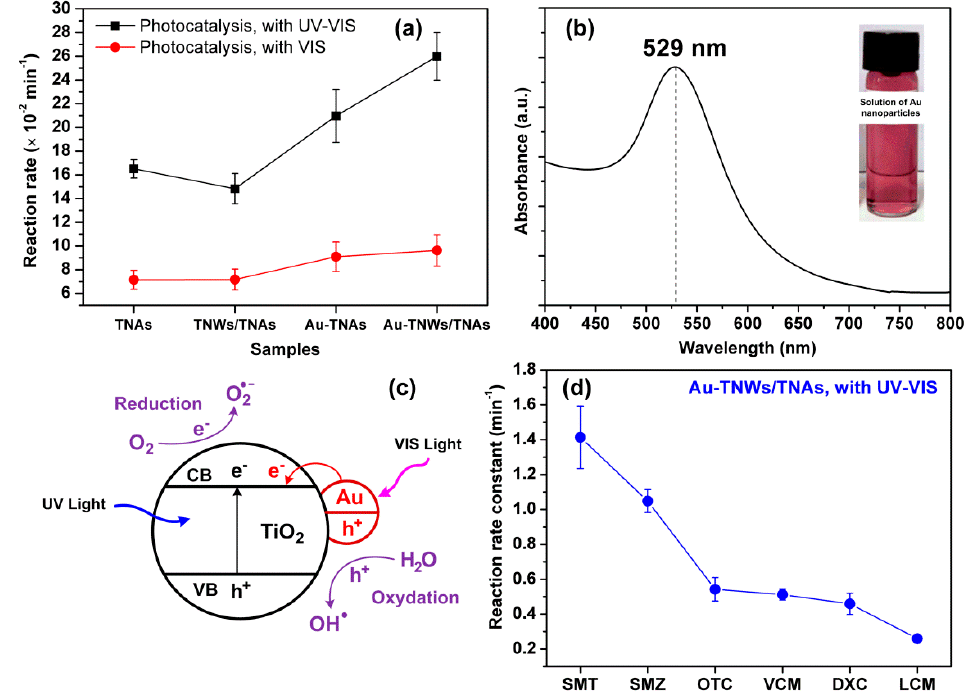
Figure 5. ( a ) Reaction rate constant ( k ) of various nanomaterials in photocatalytic degradation of Lincomycin (500 ng / mL) under UV-VIS and VIS irradiation. ( b ) Absorption spectrum of the solution of Au nanoparticles, showing the LSPR peak at 529 nm; and the inset image is a photograph of the Au nanoparticle solution. ( c ) A proposed mechanism for the photocatalytic activity of Au-TiO 2 upon the excitation of the Au surface plasmon band. ( d ) Reaction rate constant of various antibiotics under photocatalysis using Au-TNWs / TNAs under UV-VIS irradiation. The antibiotic abbreviations: SMT, sulfamethazine; VCM, vancomycin; OTC, oxytetracycline; SMZ, sulfamethoxazole; DXC, doxycycline; LCM,